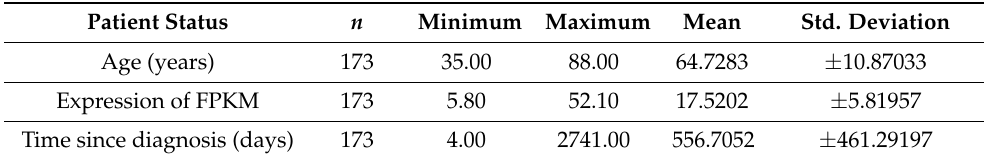
Table 2. Descriptive statistics of the data collected from The Cancer Genome Atlas (TCGA)